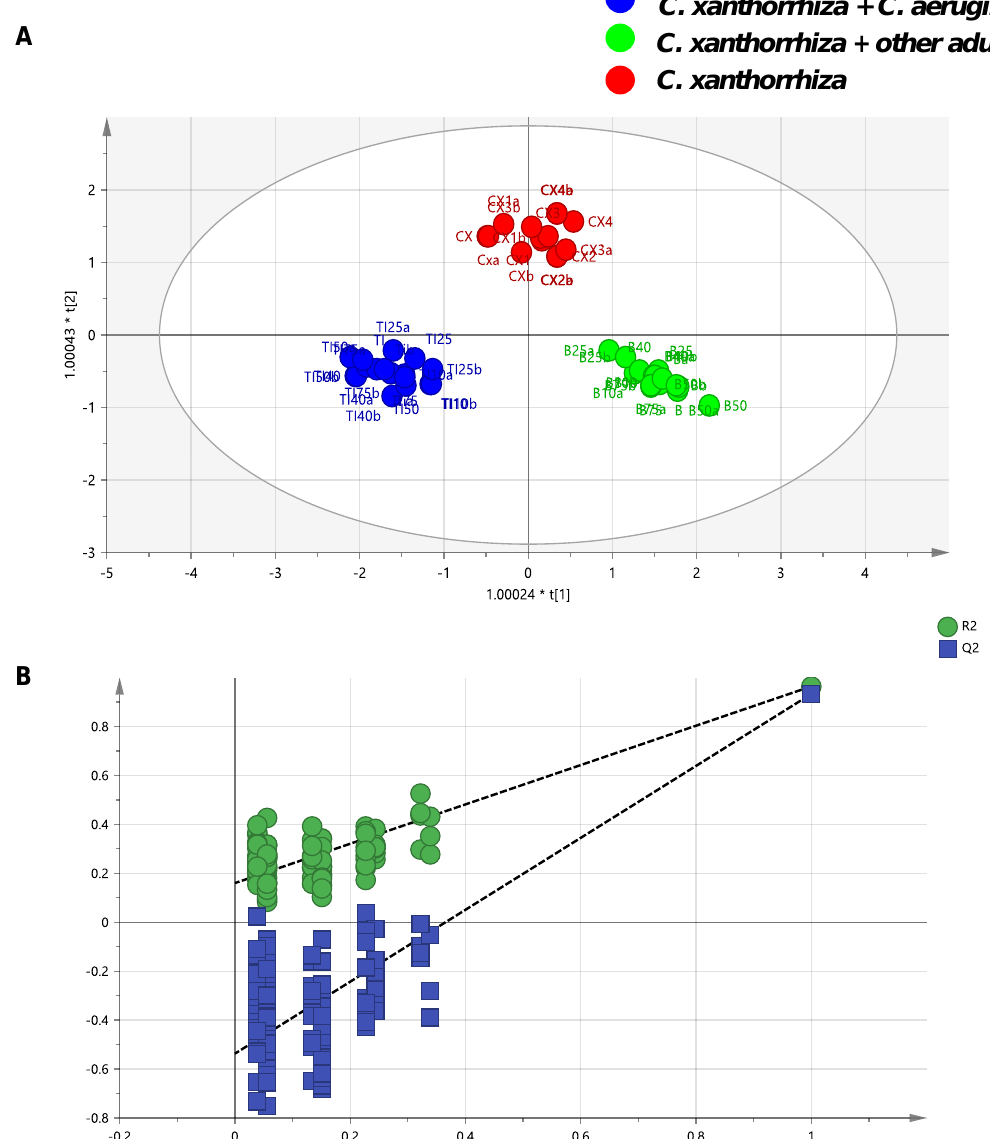
Figure 6. OPLS-DA score plot of pure and adulterated C. xanthorrhiza ( A ) and permutation test of OPLS-DA model ( B ).